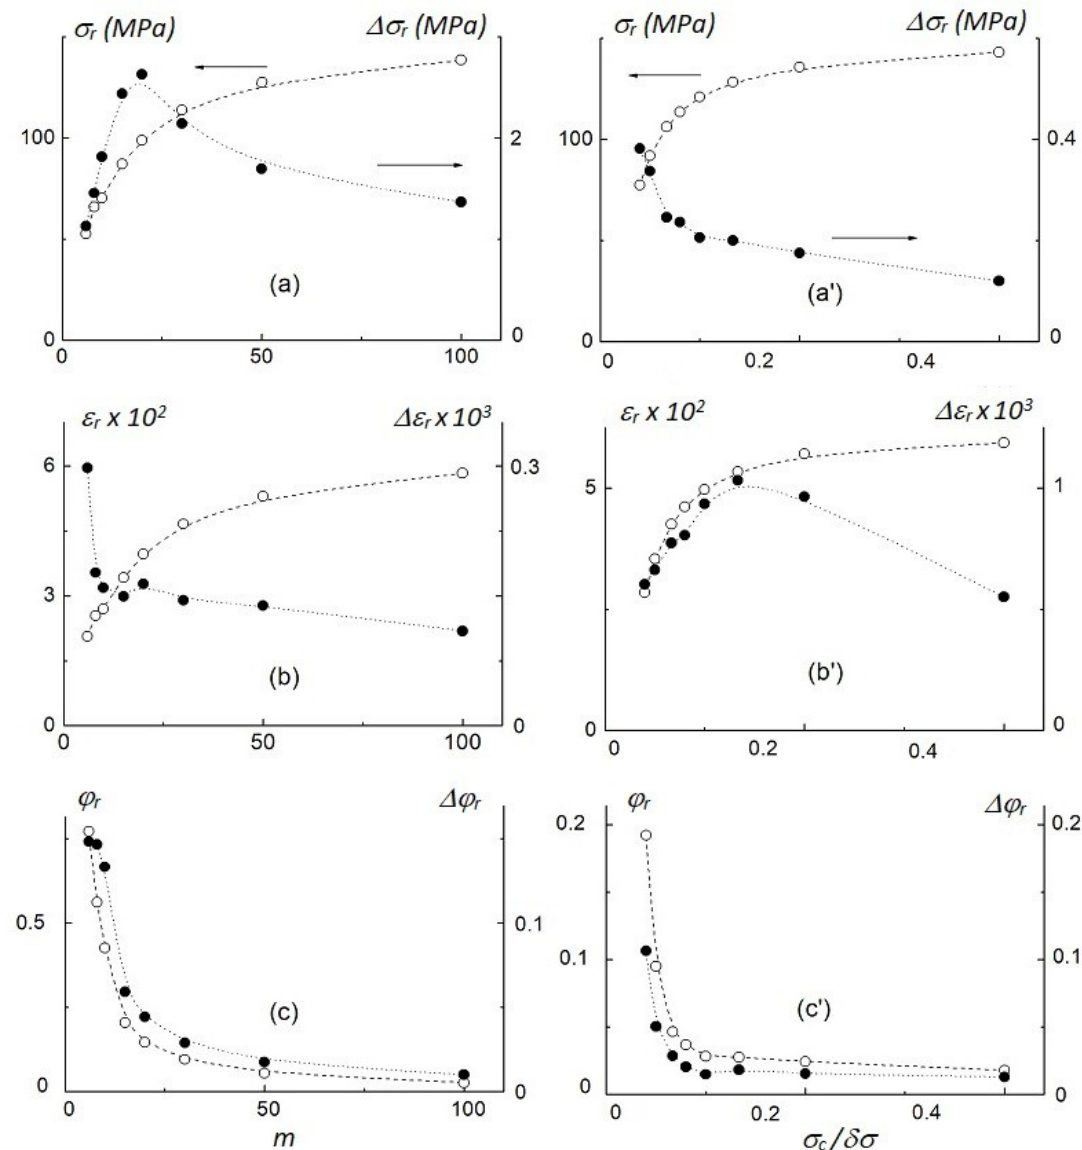
Figure 5. Simulated e ff ects of the shape factors of the particle survival laws. Left column: results of calculation for the Weibull statistics with the shape factor m . Right column: dependences on the inverse value of the shape factor δσ / σ c for the linearized failure statistics. ( a , a’ ) Mean value and dispersion of the fracture stress. ( b , b’ ) Similar data for strain. ( c , c’ ) Data for the fraction of cracked particles. In each chart, empty circles stand for the mean value of the studied quantity and filled circles trace its dispersion.